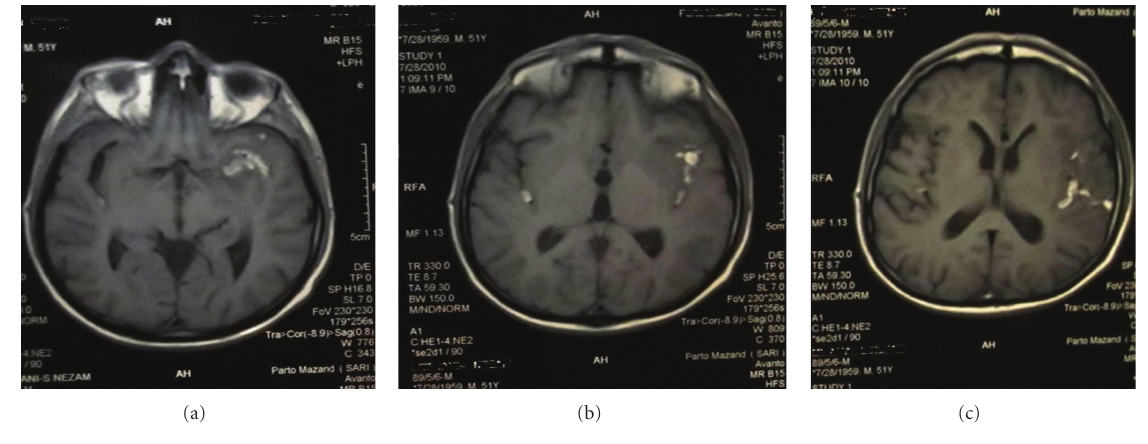
Figure 1: The patient’s CT scan.